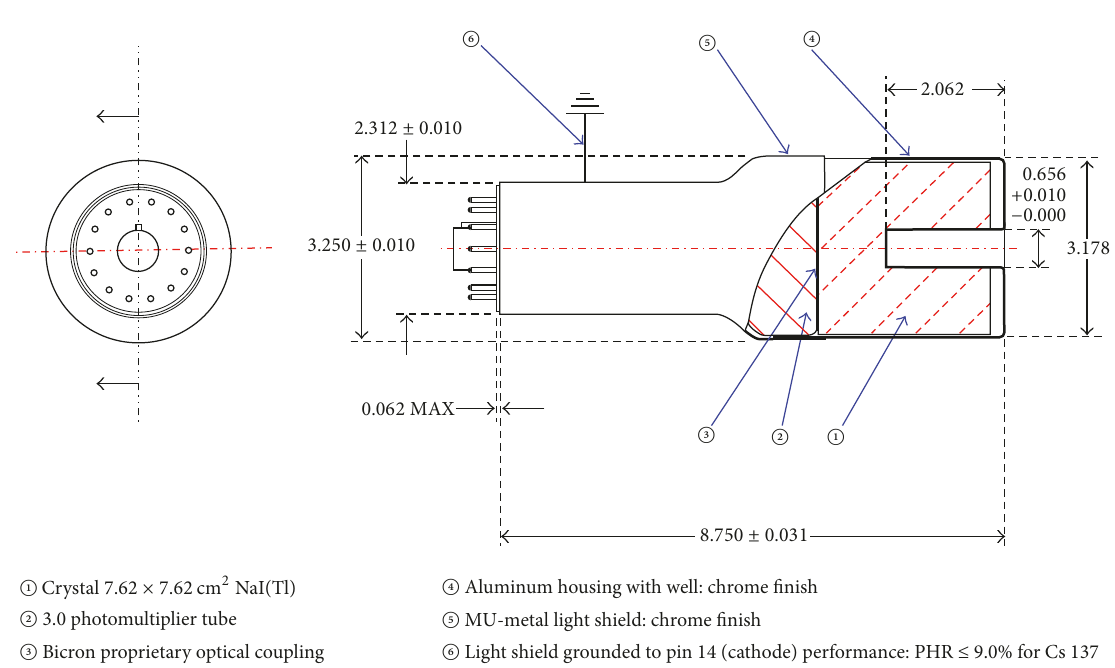
Figure 3: The manufactory diagram of 7.62 × 7.62 cm 2 well-type NaI(Tl) scintillation detector.